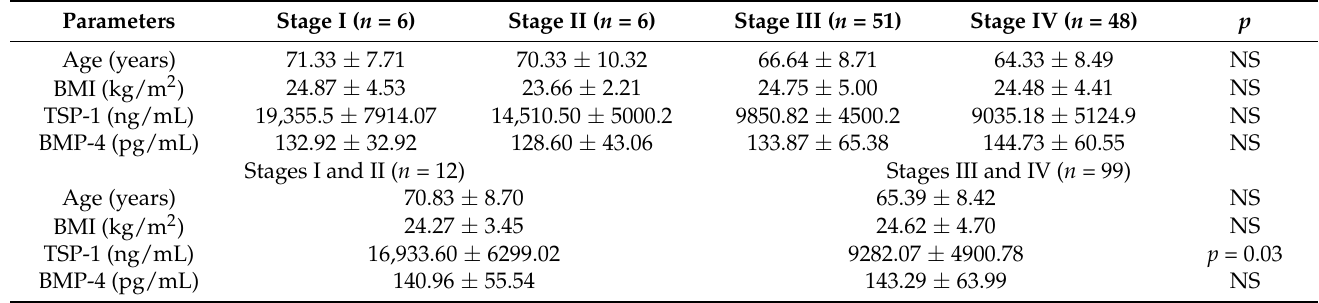
Figure 3. TSP-1 (Thrombospondin-1) serum levels in lung cancer patients with lymph nodes involvement (Group 1) and without lymph nodes involvement (Group 0). Table 1. The comparison of lung cancer patients in different stages of the disease.